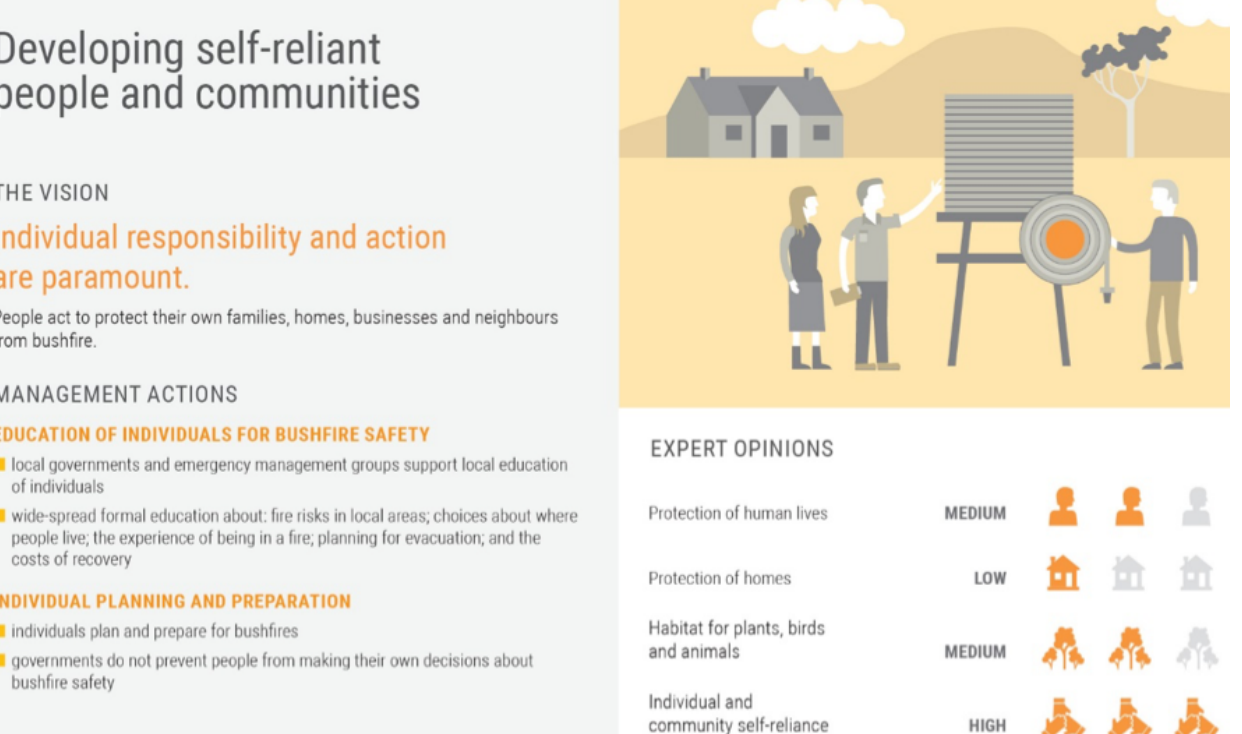
Fig. 6 . Illustration for “developing self-reliant people and communities,” one of the three scenarios refined from those developed in workshops that were shown to post-workshop interview